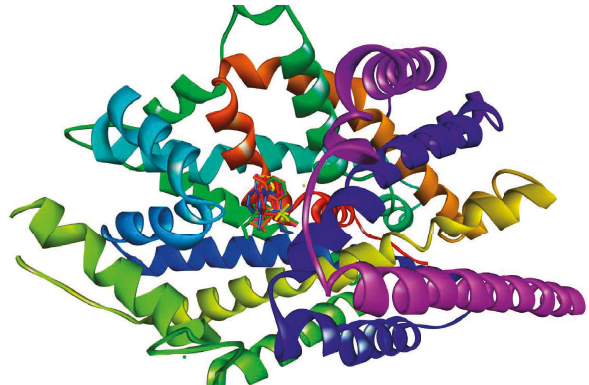
Figure 6: The docked structures of the co-crystallized ligand, desipramine (red), and standard drug maprotiline (yellow) along with the compounds 1 (orange), 2 (pink), 5 (green), and 6 (blue) in the binding site of